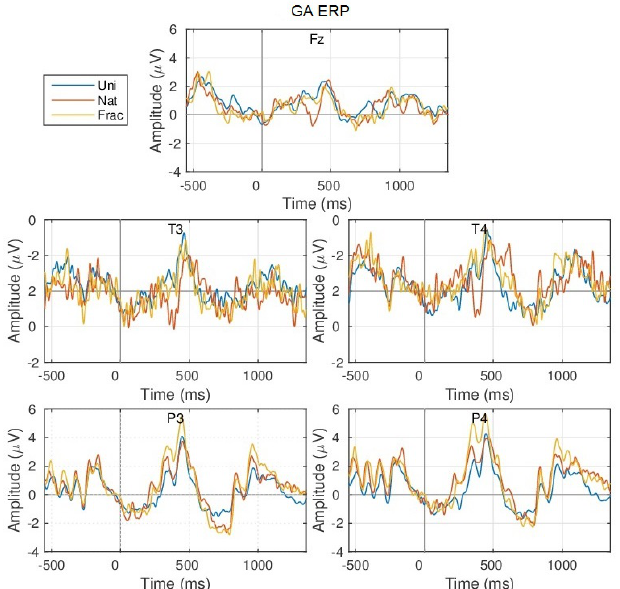
Figure A11. GA ERP responses over all blocks, for the 3 types of images: Uni (blue); Nat (red); Frac (orange), considering all channels. (Please note that temporal sites channels (T3 and T4) will appear nosier in the graphics, while their conductivity was lower compared to the other channels, since they were a bit loose during experiments due to their placement on the EEG cap lateral